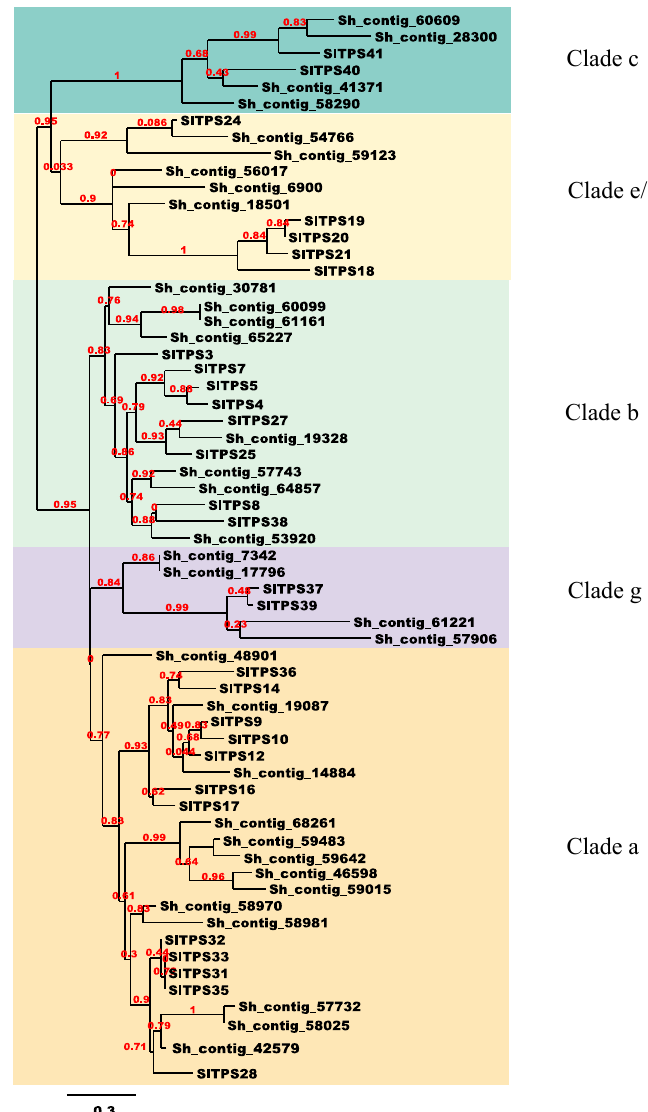
Figure 6. Phylogenetic analysis of S. hispanica Terpene synthase proteins. Maximum-likelihood phylogenetic tree of putative Salvia hispanica and Solanum lycopersicum Terpene synthase proteins. Bootstrap values for 100 replicates are indicated in red. “Sh” and “Sl” refer to Salvia hispanica and Solanum lycopersicum , respectively.